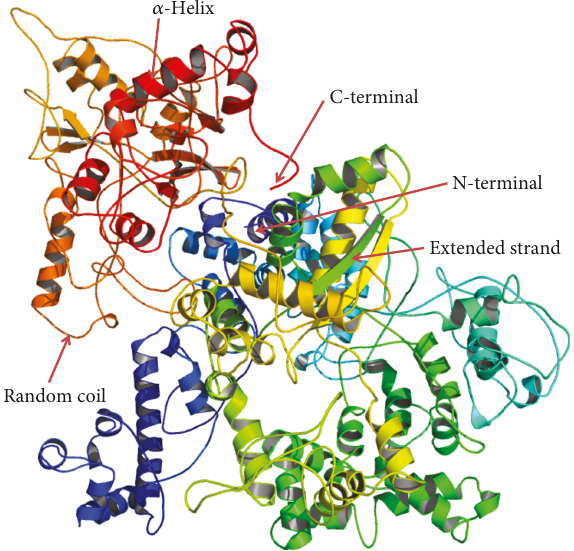
Figure 7: Three-dimensional structure of the OROV polyprotein. This protein model was predicted by the I-TASSER server and visualized by the PyMOL molecular graphics